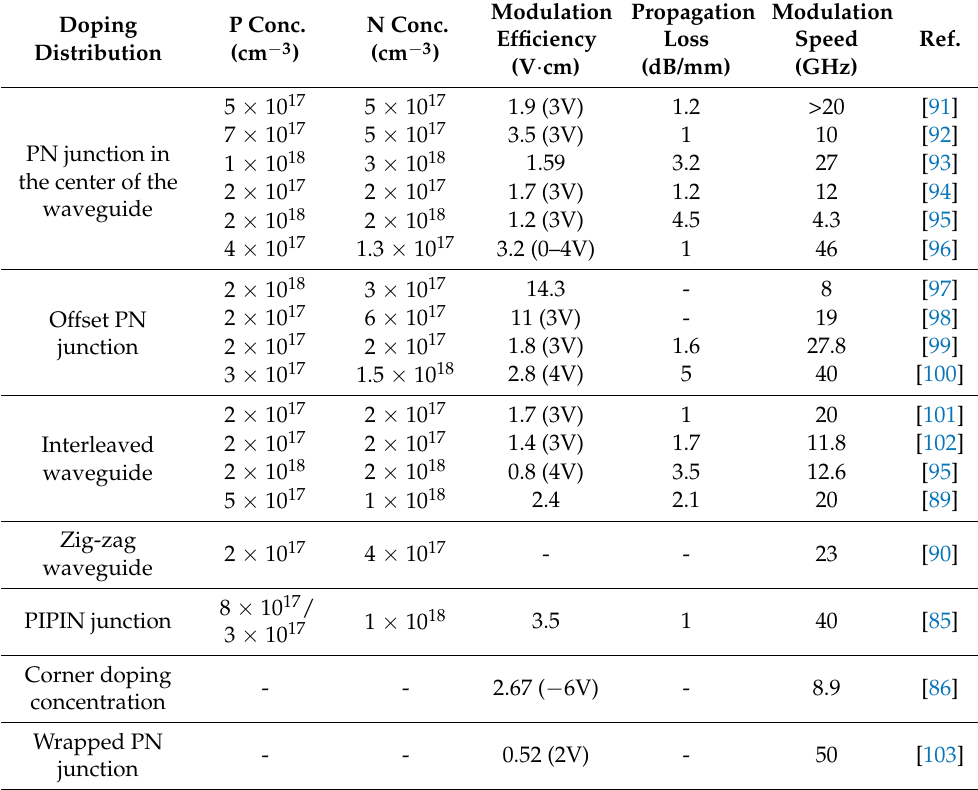
Table 3. Performance summary of free-carrier-depletion-based phase